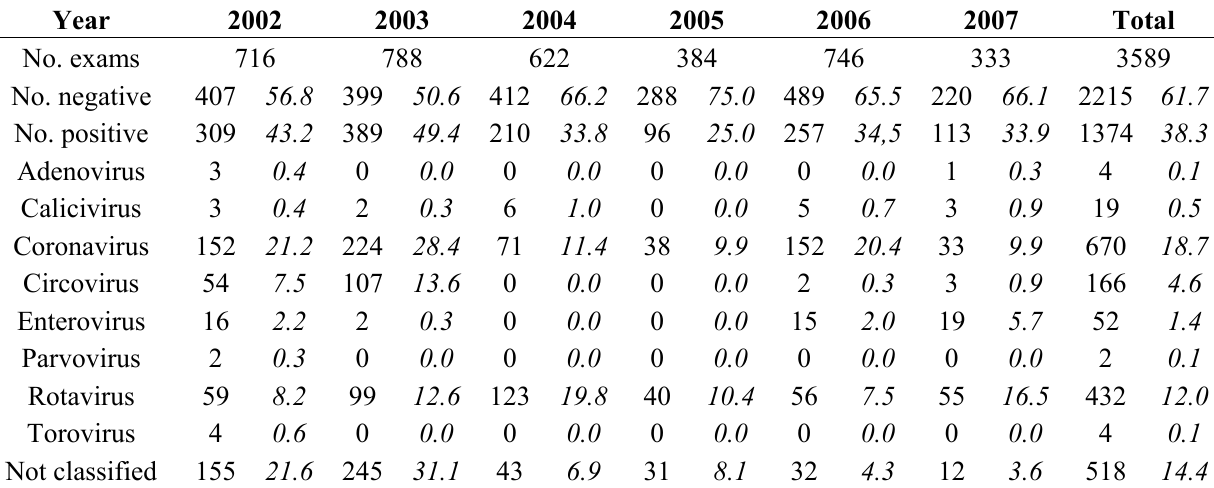
Table 1. Results of IAEM examination of fecal or intestinal samples from pigs with enteric disease (2002–2007). The category “not classified” includes “enterovirus-like viruses” and the so-called “small round fecal viruses”. The numbers in italics indicate the percentages calculated based on the total examinations performed each year. The percentage of the positives exams is based on the total examinations although some examinations resulted in more than one positive identification due to the occurrence of multiple infections with two or more viruses in